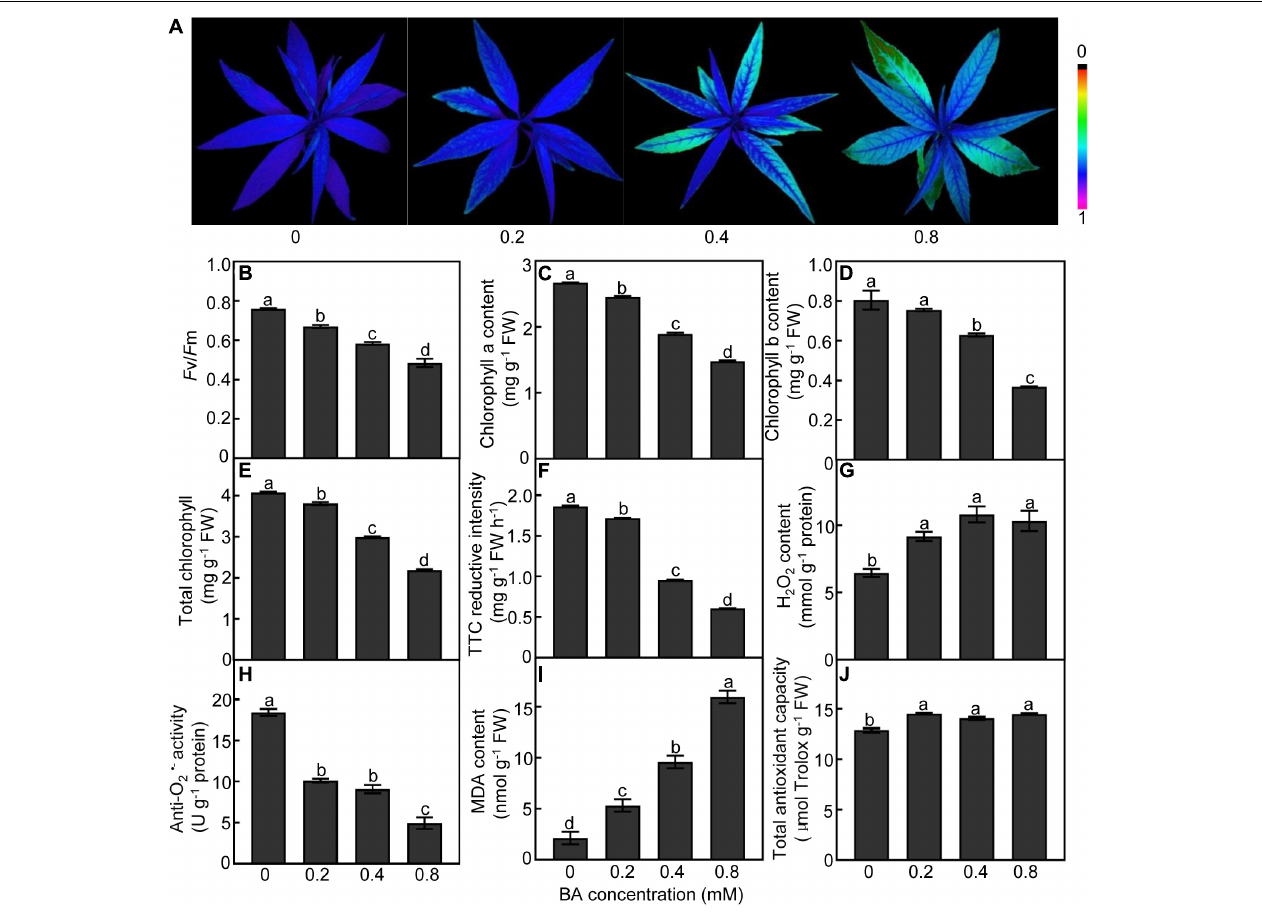
FIGURE 2 | Physiological response of peach plants after BA treated for 120 h. (A) Chlorophyll fluorescence imaging. (B) Maximum potential of PSII efficiency ( F v/ F m). (C) Chlorophyll a content. (D) Chlorophyll b content. (E) Total chlorophyll content. (F) Root vigor. (G) H 2 O 2 content. (H) Anti-O 2 •− activity (a parameter negatively proportional to O 2 •− level). (I) MDA content. (J) Total antioxidant capacity. Data are means ± SE ( n = 3). Different letters on top of bars denote significant differences between treatments at P <